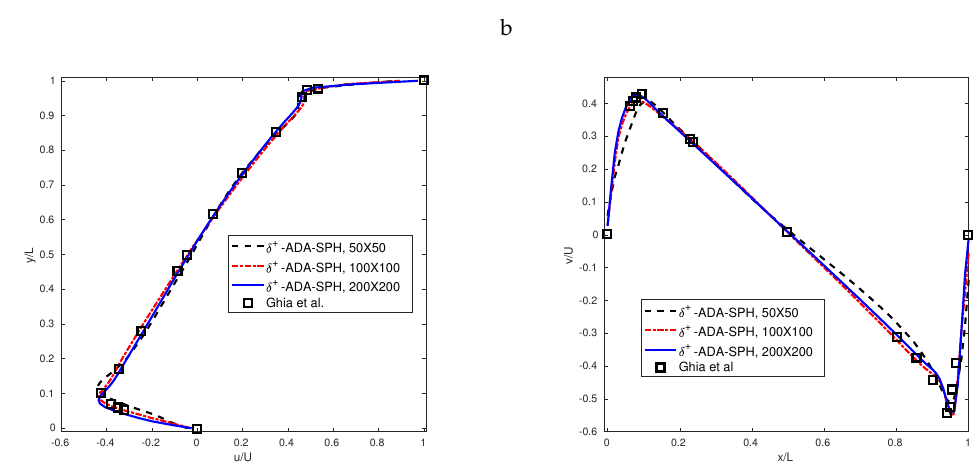
Figure 11. Lid-driven cavity flow: Normalized velocity profiles along vertical ( a ) and horizontal ( b ) centerlines, computed for Reynolds number Re = 3200 using 50 × 50, 100 × 100 and 200 × 200 particles. The solutions are compared with those of Ghia [42].